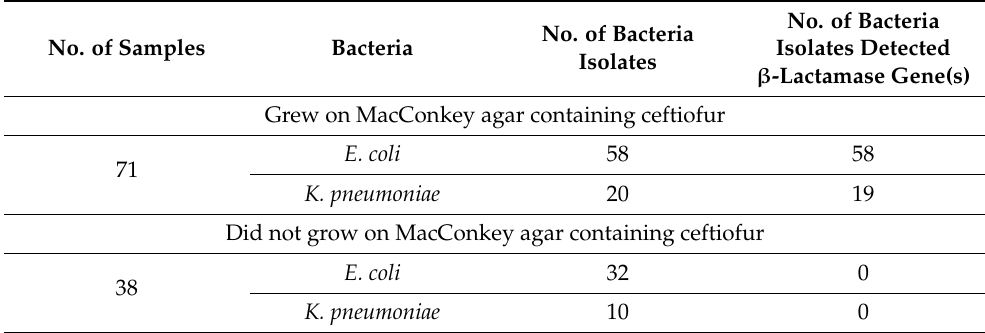
Table 4. Distribution of E. coli and K. pneumoniae isolates from dog and cat samples.